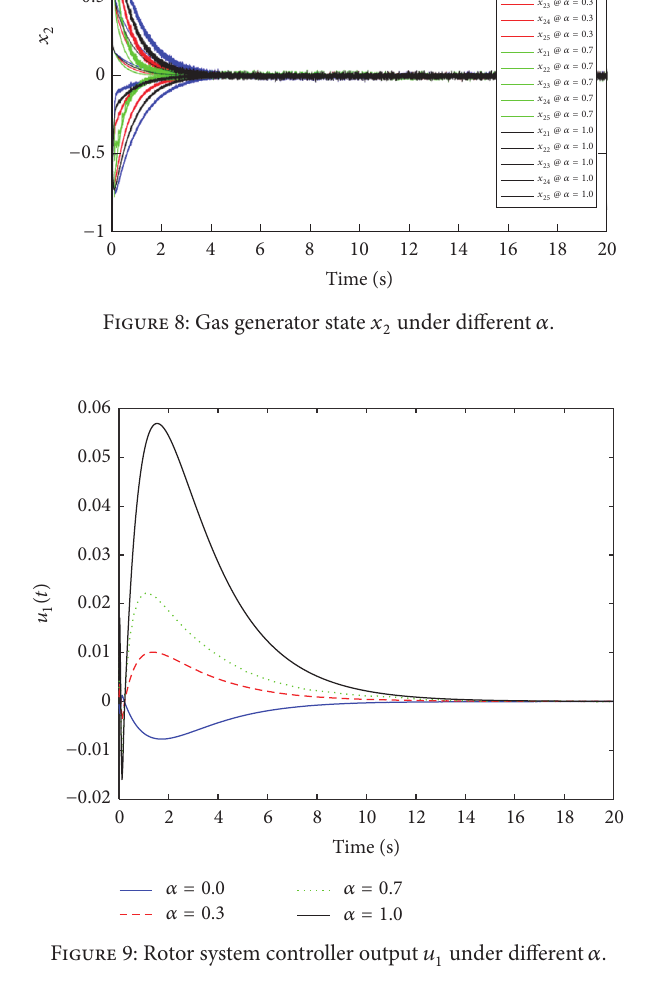
Figure 11: Gas generator controller output 𝑢 2 under different 𝛼 (partial